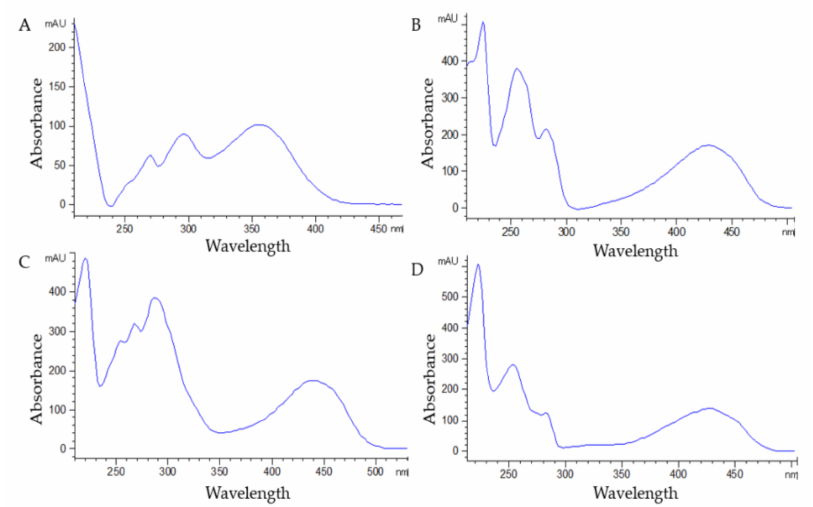
Figure 3. UV–Vis spectra of HAD reference standards: aloin A or aloin B ( A ), aloe emodin ( B ), emodin ( C ), and danthron ( D ).